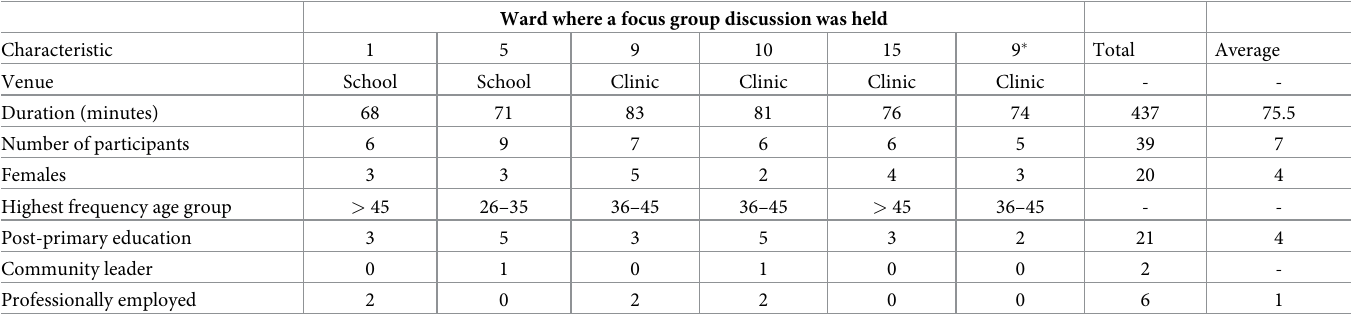
Table 5. Characteristics of participants in focus groups, Mbire district, northern Zimbabwe, 2021 (n = 39). Ward where a focus group discussion was